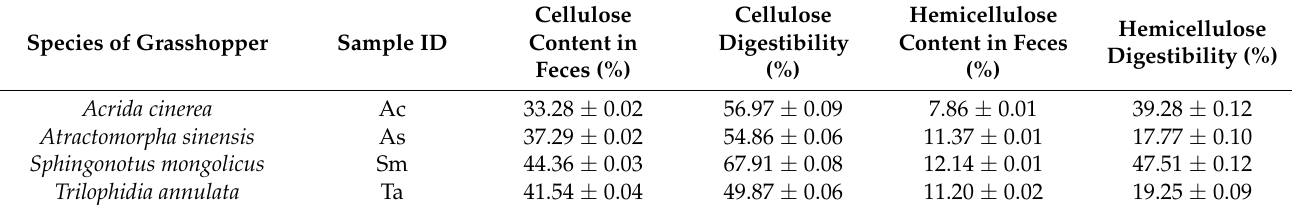
Table 4. The content and digestibility of cellulose and hemicellulose.